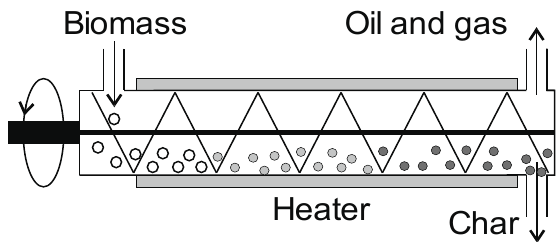
Figure 9. Diagram of a reactor with a screw.